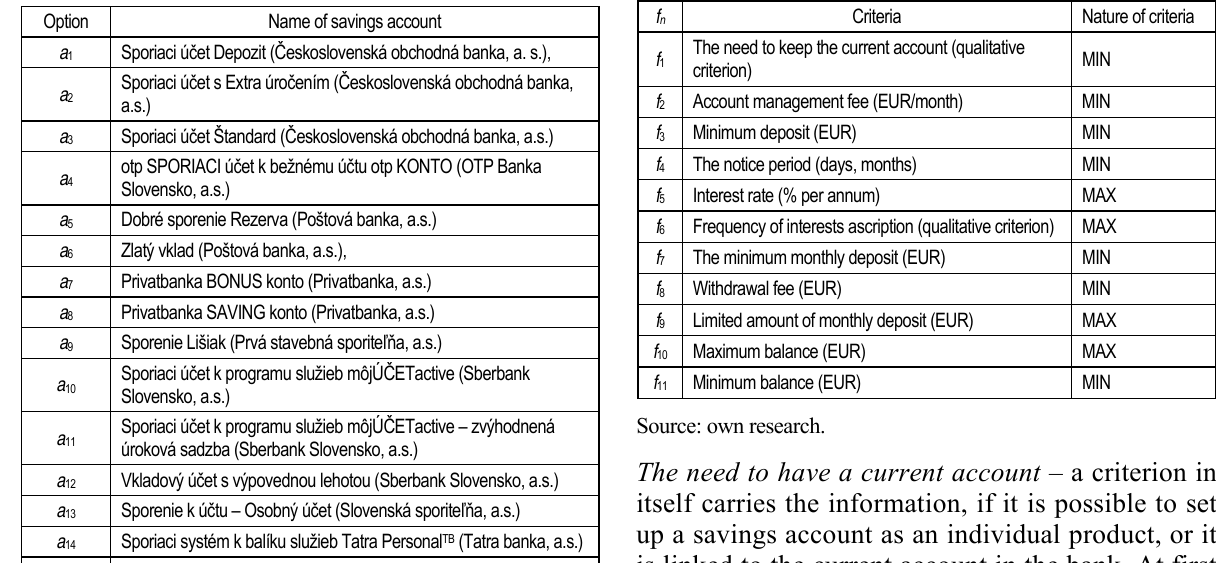
Table 3. The list of criteria for selection of